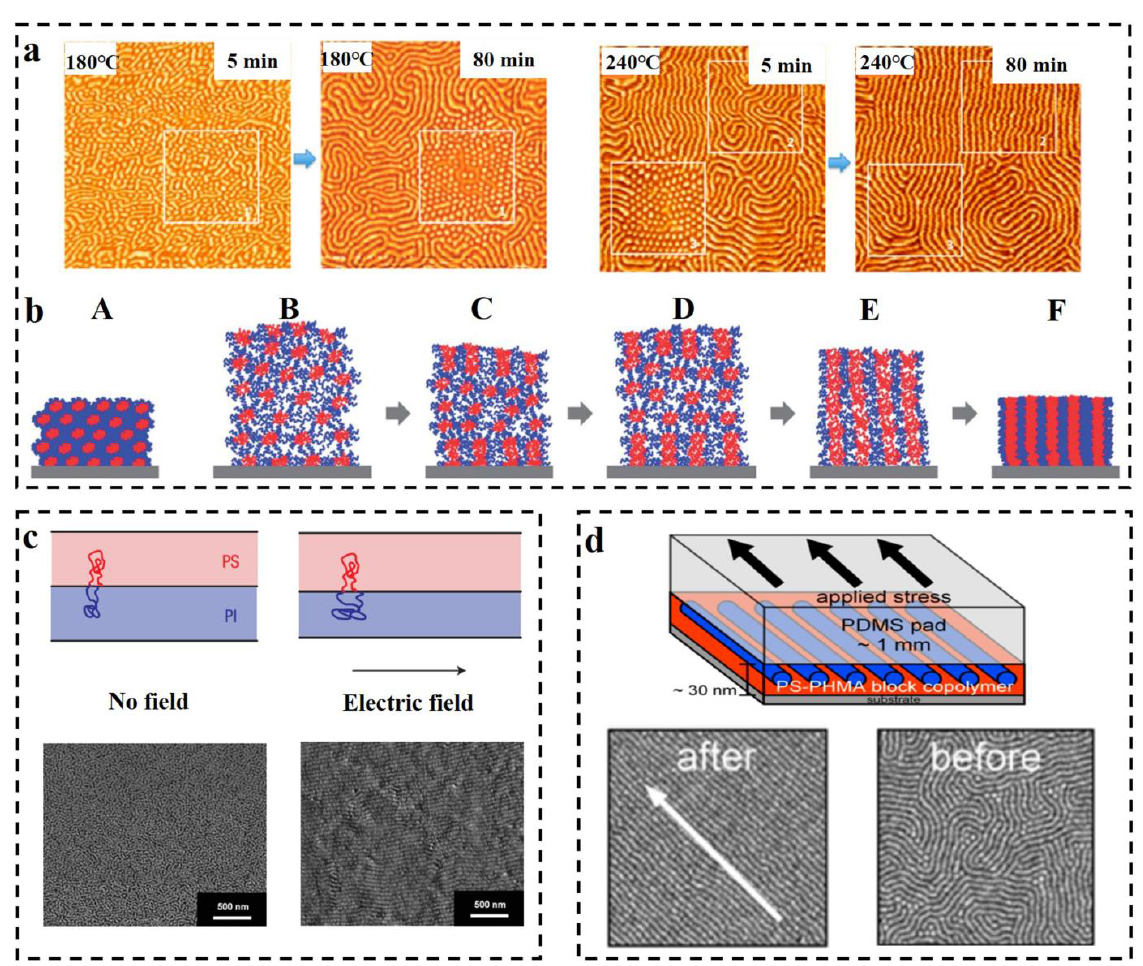
Figure 6. ( a ) In situ AFM image s (1.25 × 1.25 μm 2 ) of PS-b-PMMA obtained by thermal annealing